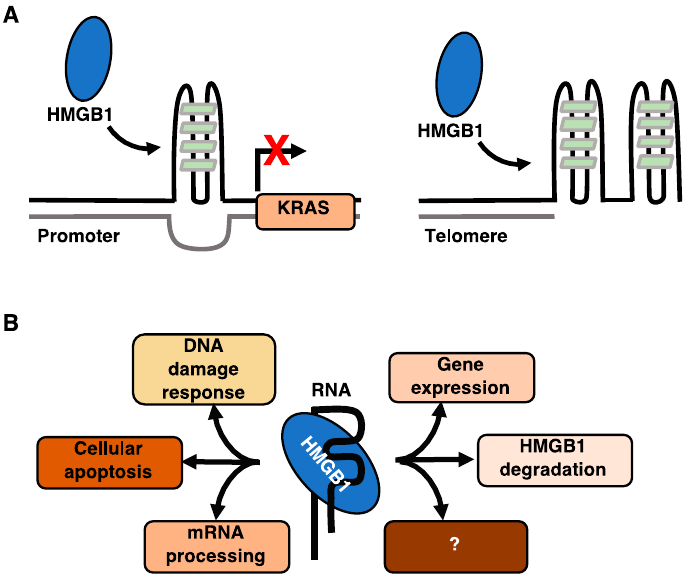
Figure 3. ( A ) HMGB1 binding to the KRAS and telomeric G4-quadruplexes. ( B ) HMGB1/RNA interactions can impact multiple cellular processes.